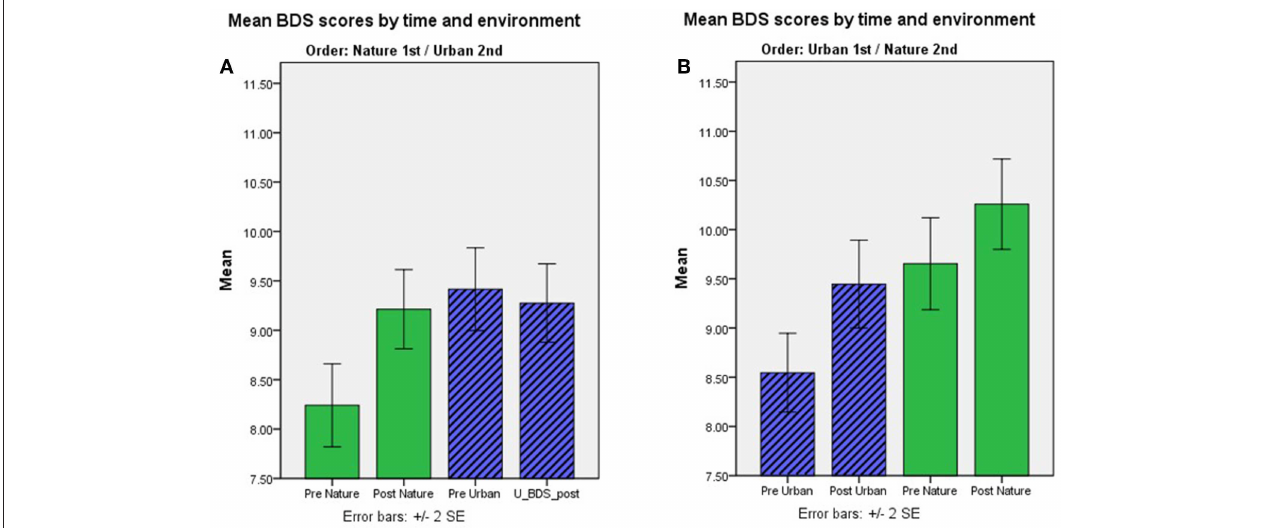
FIGURE 2 | (A,B) BDS performance scores pre- and post-nature vs. urban environment interactions, by order of environment conditions. Aggregated results for study samples with environment as a within-subjects factor. Mean BDS scores by time and environment condition, for the order of conditions nature 1st and urban 2nd; (A) and urban 1st and nature 2nd (B)